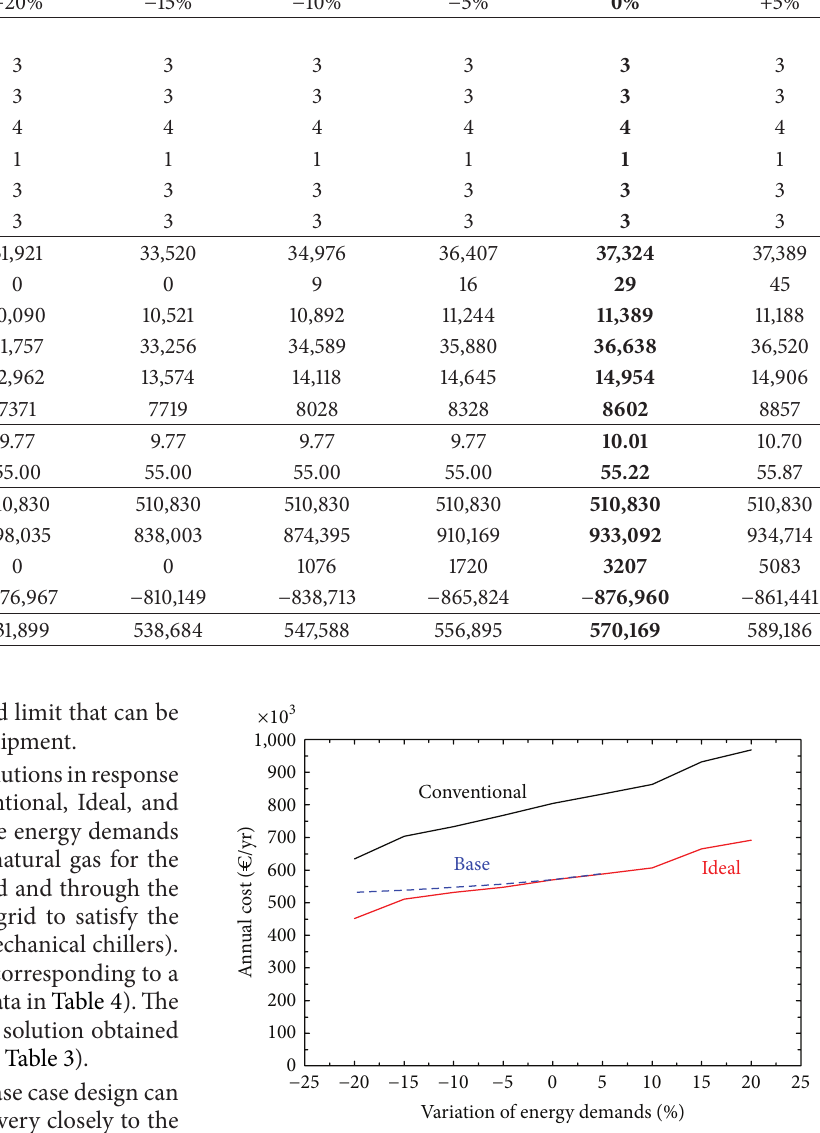
Figure 4: Behavior of solutions in response to variations in energy